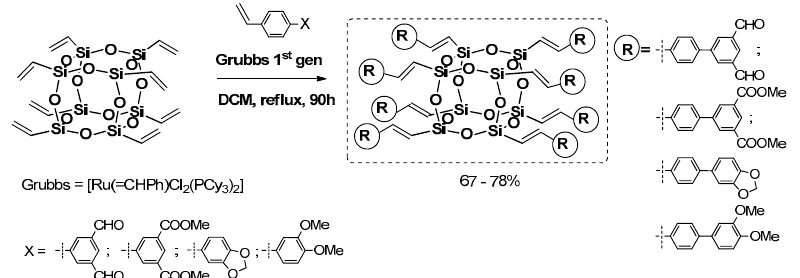
Figure 16. Cross-metathetic reaction path for the synthesis of octa(styryl)silsesquioxane.